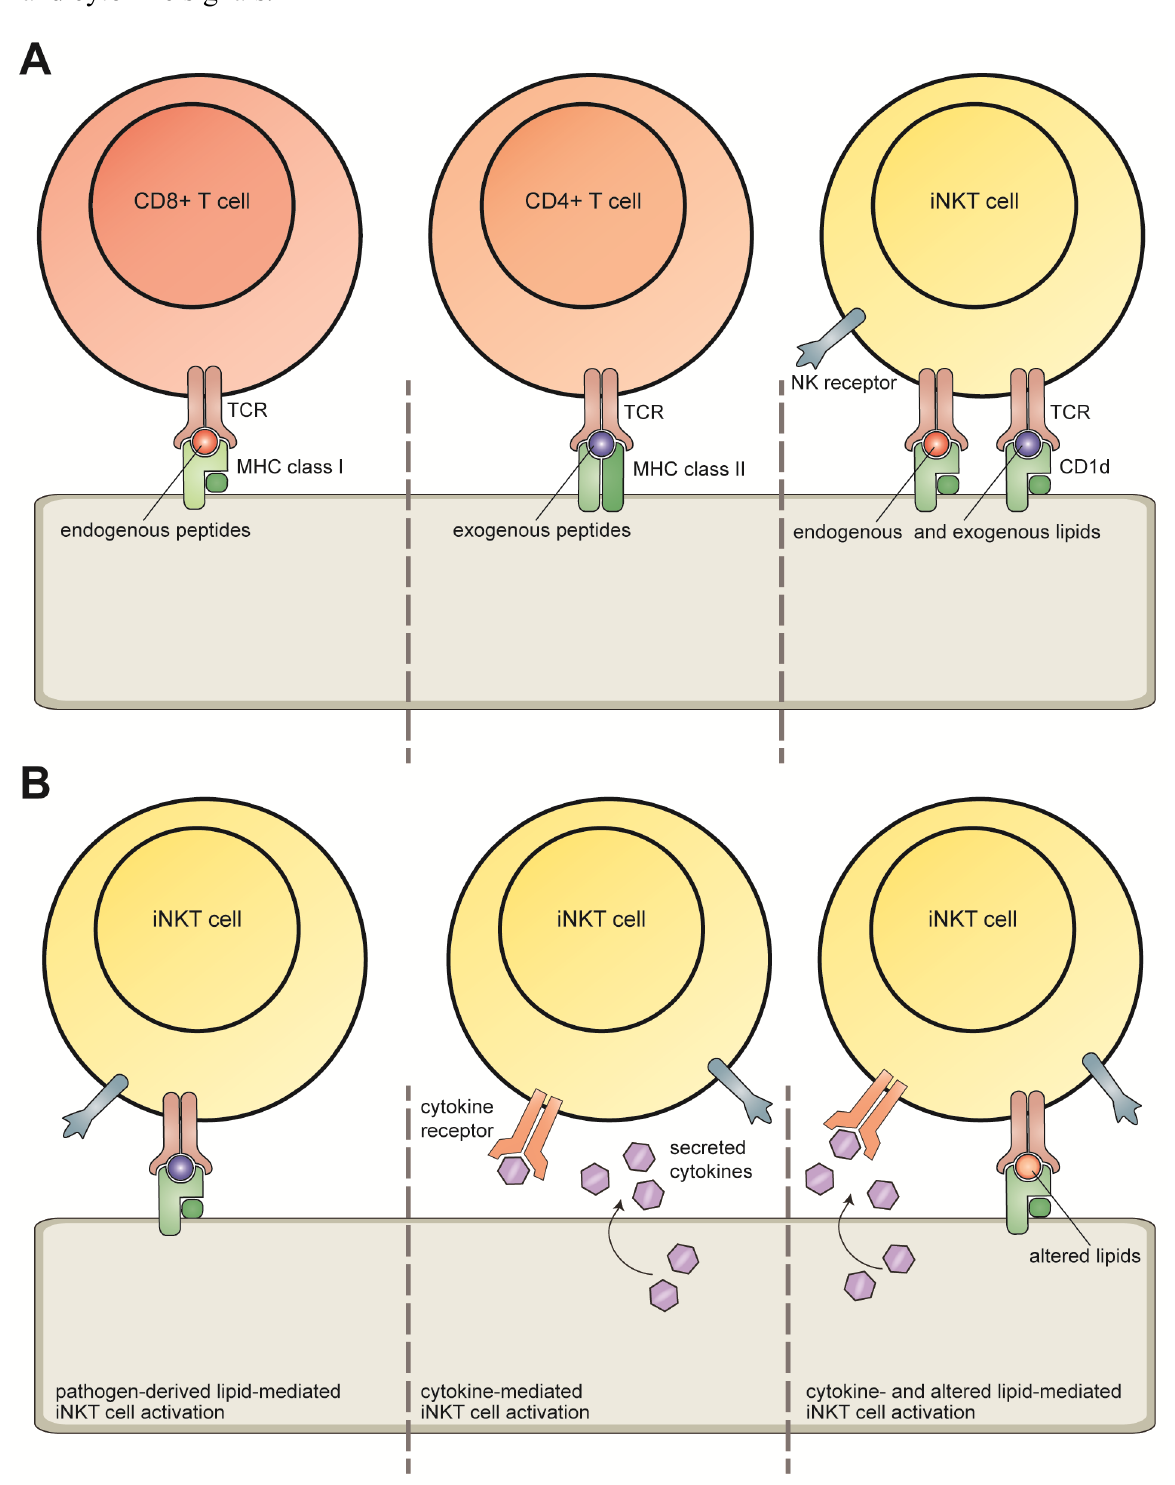
Figure 1. ( A ) MHC- and CD1d-restricted antigen presentation. In general, MHC class I molecules present endogenous peptides to CD8 + T cells, whereas MHC class II molecules present exogenous peptides to CD4 + T cells. Both endogenous and exogenous lipids are presented by the non-classical MHC molecule CD1d to invariant natural killer T (iNKT) cells. ( B ) iNKT cell activation. iNKT cells can be activated by pathogen-derived lipid antigens, innate or cytokine signals, and a combination of altered self-lipid antigens and cytokine